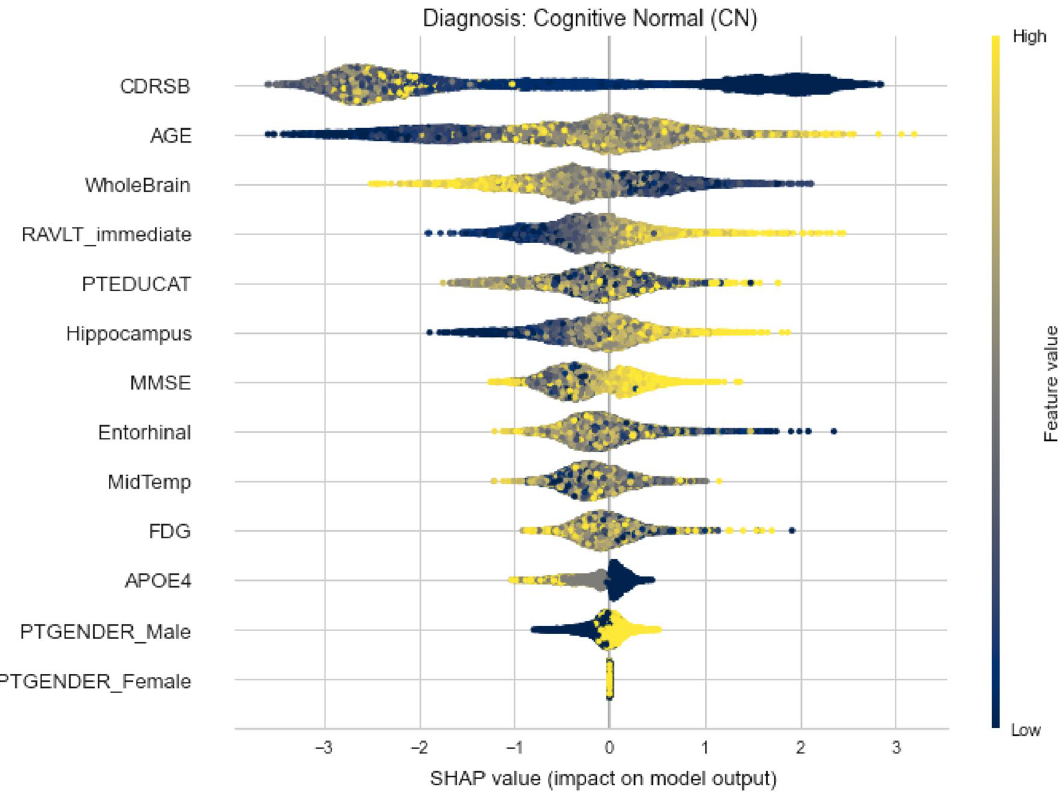
Figure 12. Variables importance plot for CN